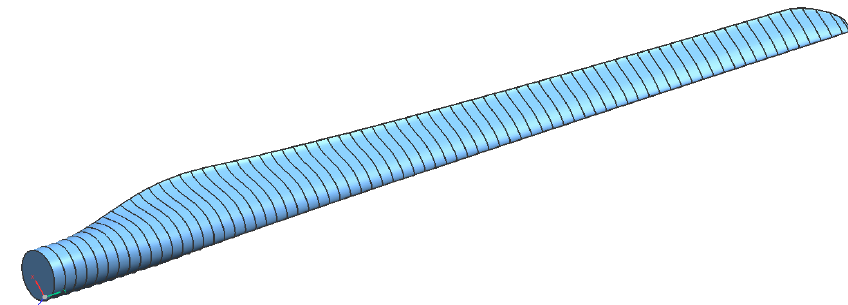
Figure 1. Aerodynamic configuration of the 1.5 MW